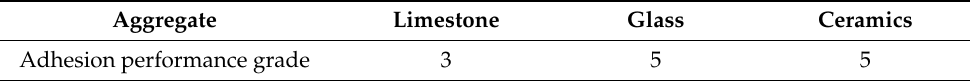
Table 11. Adhesion performance grade between bitumen and aggregate. Spalling Situation of Bitumen Membrane on Aadhesion Performance Grade Aggregate Surface The percentage of spalling area is close to 0% 5 The percentage of spalling area is less than 10% 4 The percentage of spalling area is less than 30% 3 The percentage of spalling area is more than 30% 2 All bitumen floats on the water 1